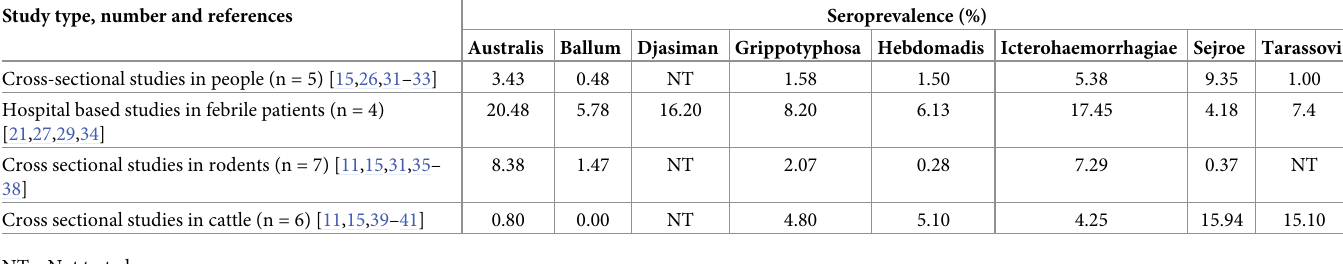
Table 1. Mean prevalence of antibodies to Leptospira serogroups in people in cross-sectional studies; in febrile patients; in rodents; in cattle in Tanzania in leptospi- rosis papers published 1997–2021. Study type, number and